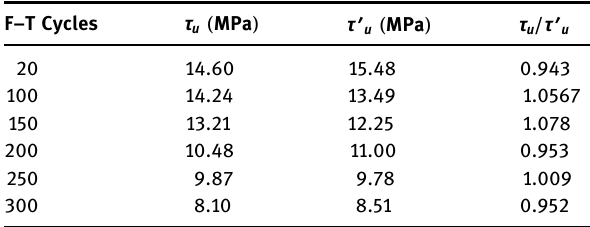
Table 3: Bond strength experimental values ( ) τ u and bond strength